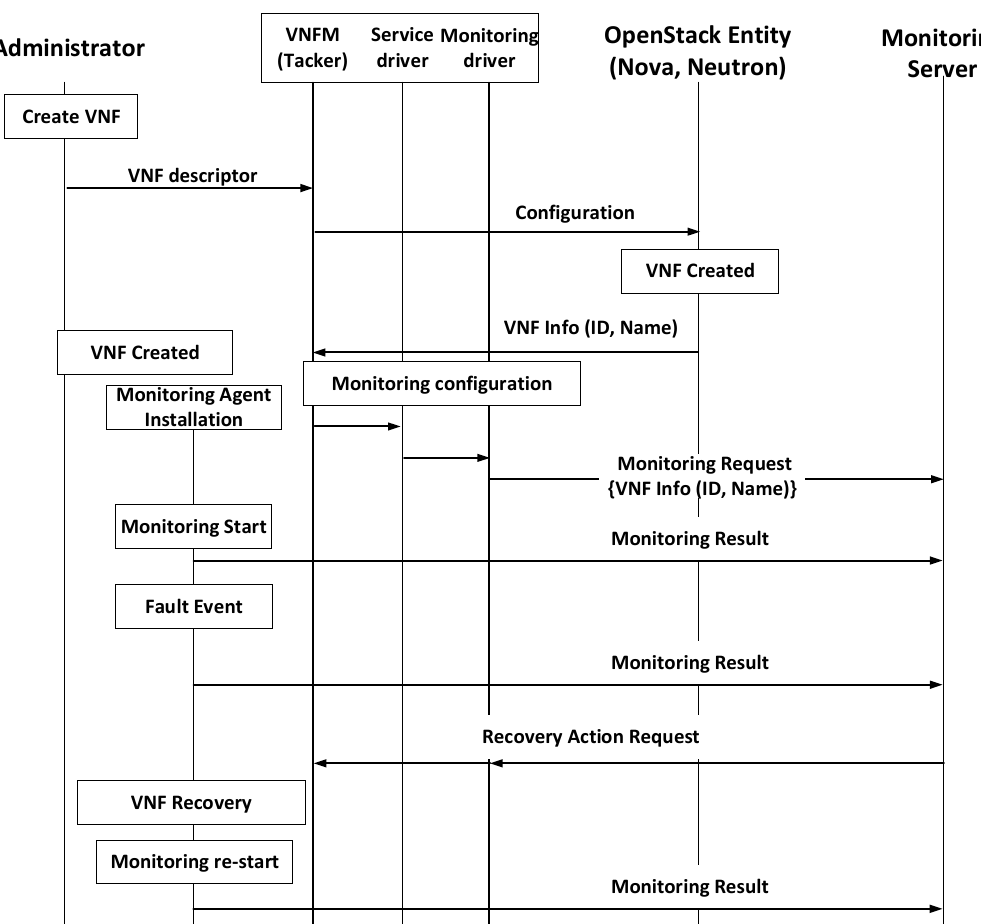
Figure 3. Procedure for service (Virtual Network Function (VNF)) fault management .